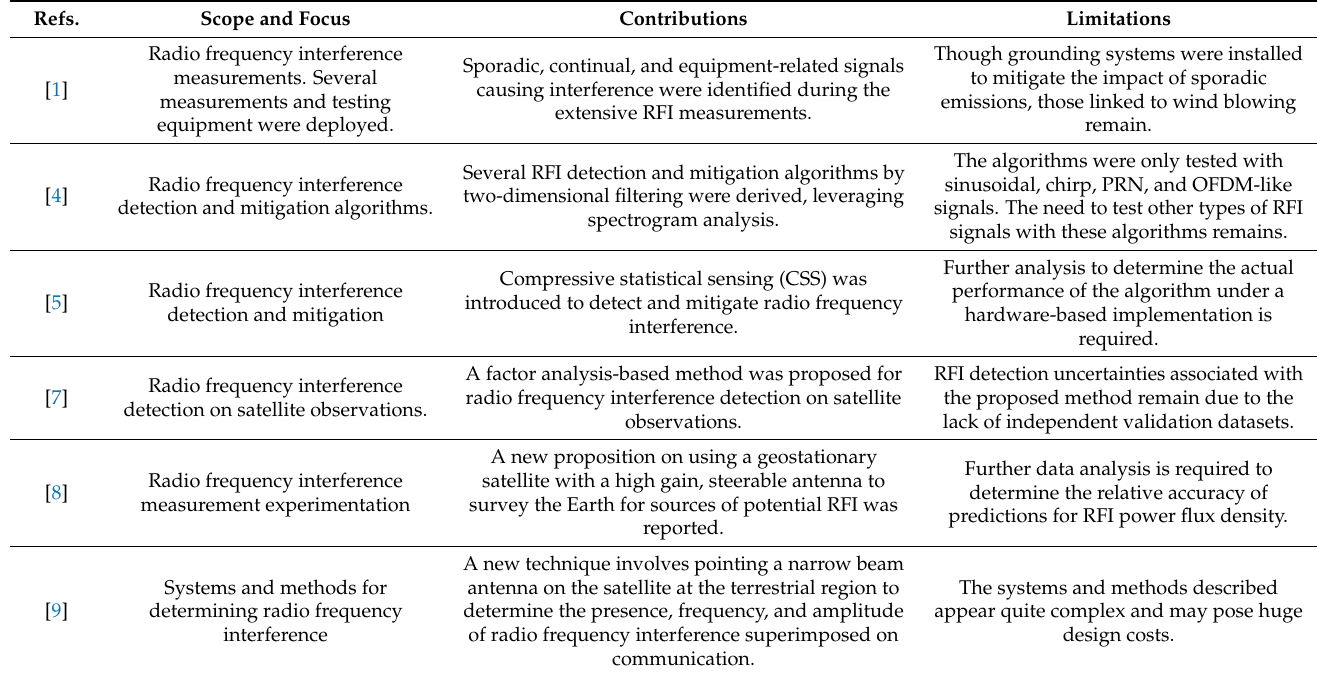
Table 2. Summary of related works, including contributions, key findings and limitations.